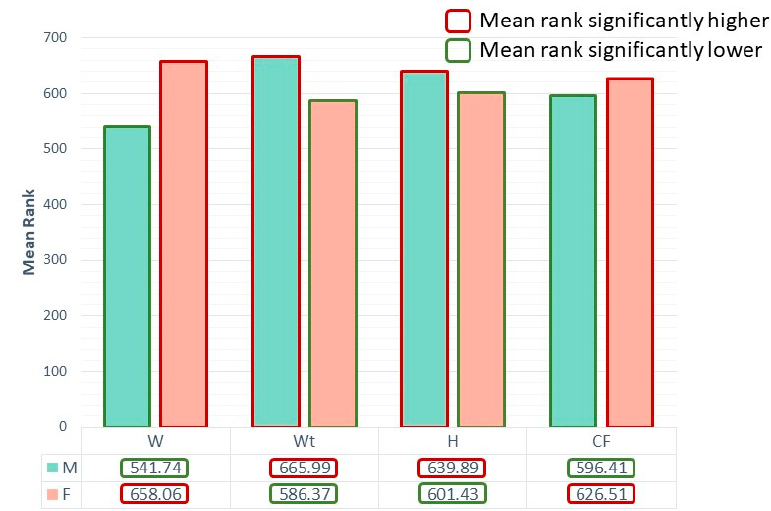
Figure 4. Kruskal-Wallis one-way ANOVA independent sample multiple comparisons of gender. Note: W: waterscape; WT: weather; H: heritage; CF: customs and festivals; A: architecture; FC: folk culture; G: gastronomy; M: male; F: female.